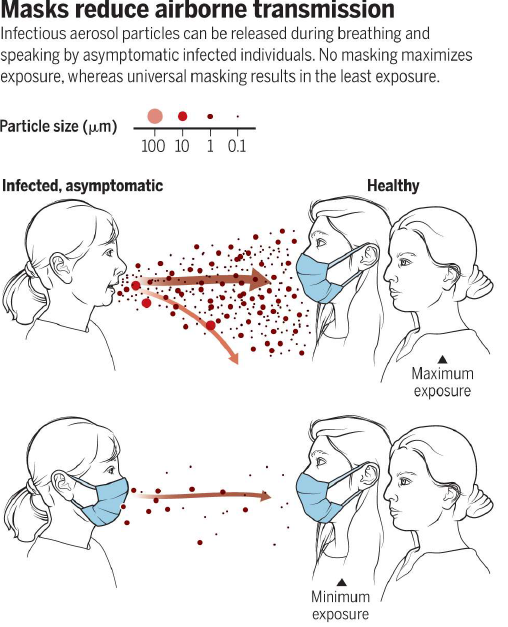
Figure 1. How face masks help reduced airborne transmission Reproduced with permission from reference. [9]. Copyright (2020), Science.